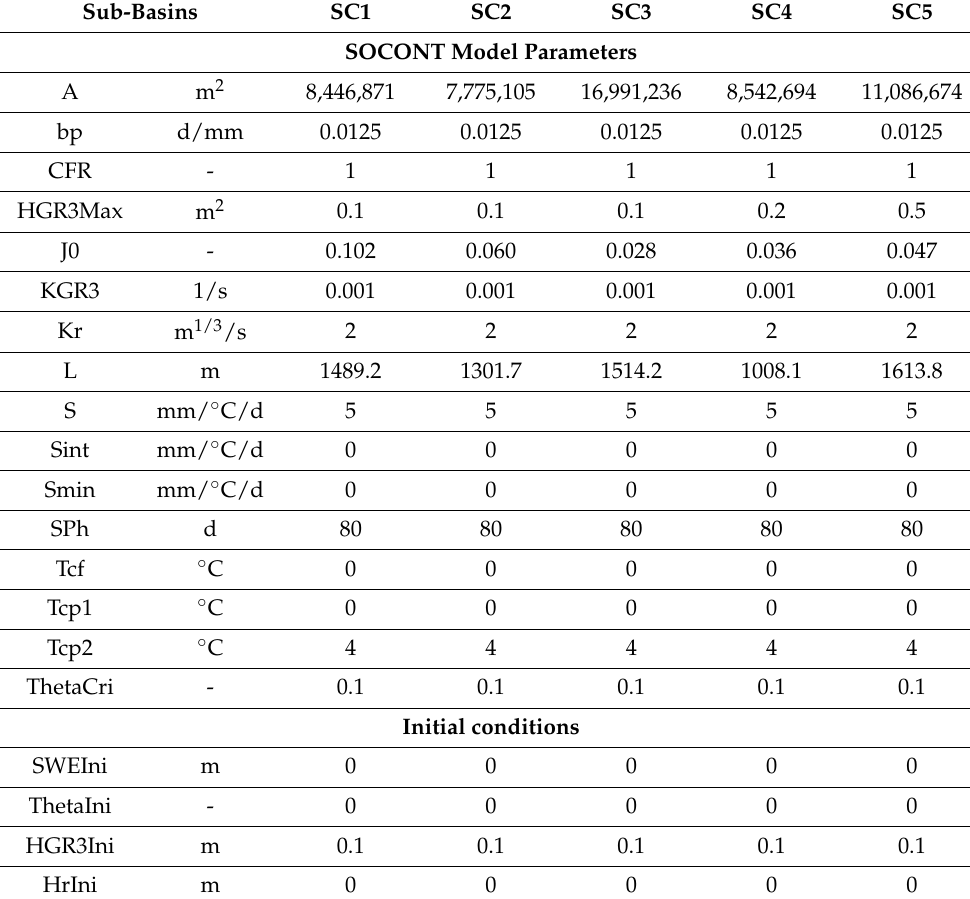
Table 8. SOCONT model parameters for each sub-basin.